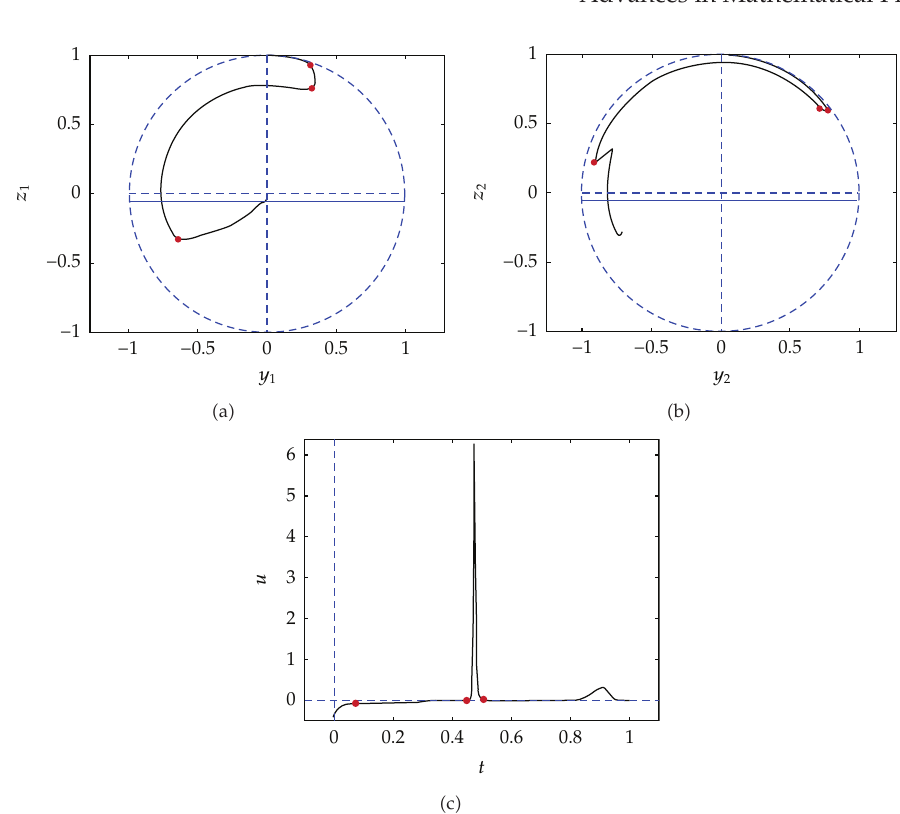
Figure 8: Trajectories of the magnetization vector for the first and second spins for the control field represented in the bottom panel. This field is the solution of the homotopy problem for λ (cid:5) 0 . 93. The red points indicate the possible structure of the solution in terms of bang and singular extremals (cid:3) see the text (cid:4)